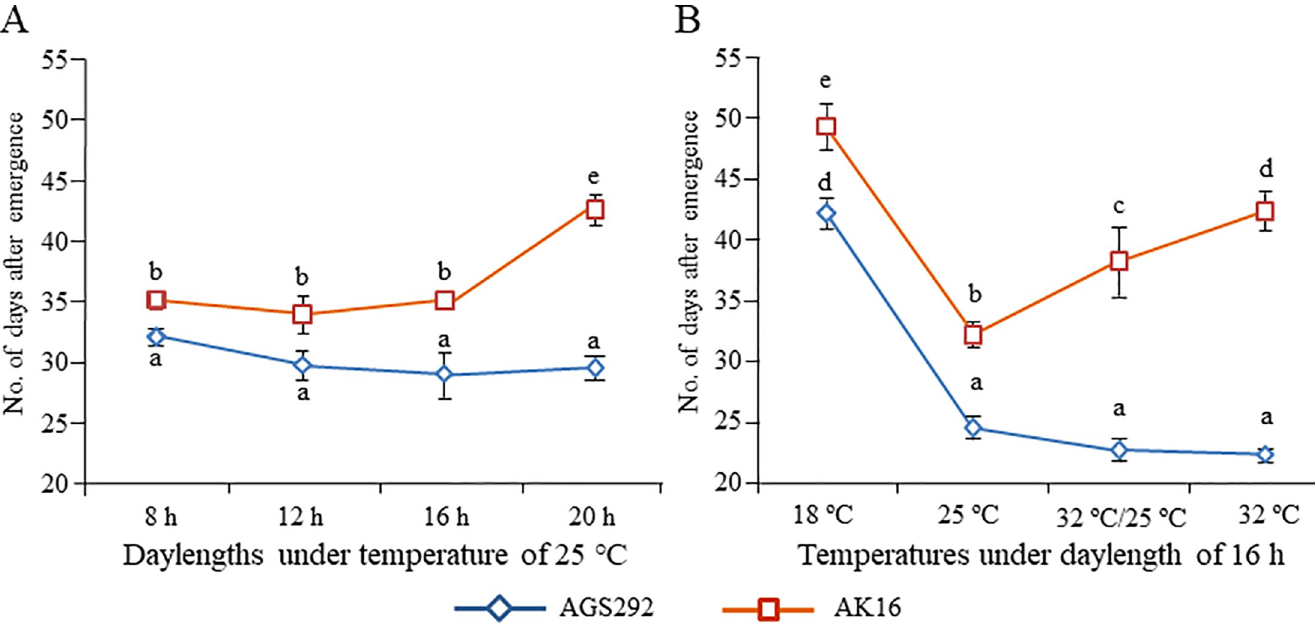
Fig 1. Flowering times of photoperiod-insensitive soybean lines AGS292 and AK16 under different photo-thermal conditions. (A) Flowering times under four photoperiod conditions (8, 12, 16 and 20 h) at a constant 25˚C. (B) Flowering times under four thermal conditions, three constant (18˚C, 25˚C and 32˚C) and one variable (32˚C in the daytime and 25˚C in the nighttime) with a 16-h day length. Different letters indicate significant differences at the 5% level in flowering times among lines/conditions as assessed using the Tukey–Kramer